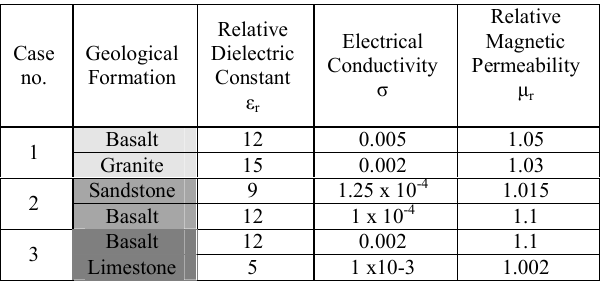
Table 3: Physical Properties of the three Forward case studies used in paper.